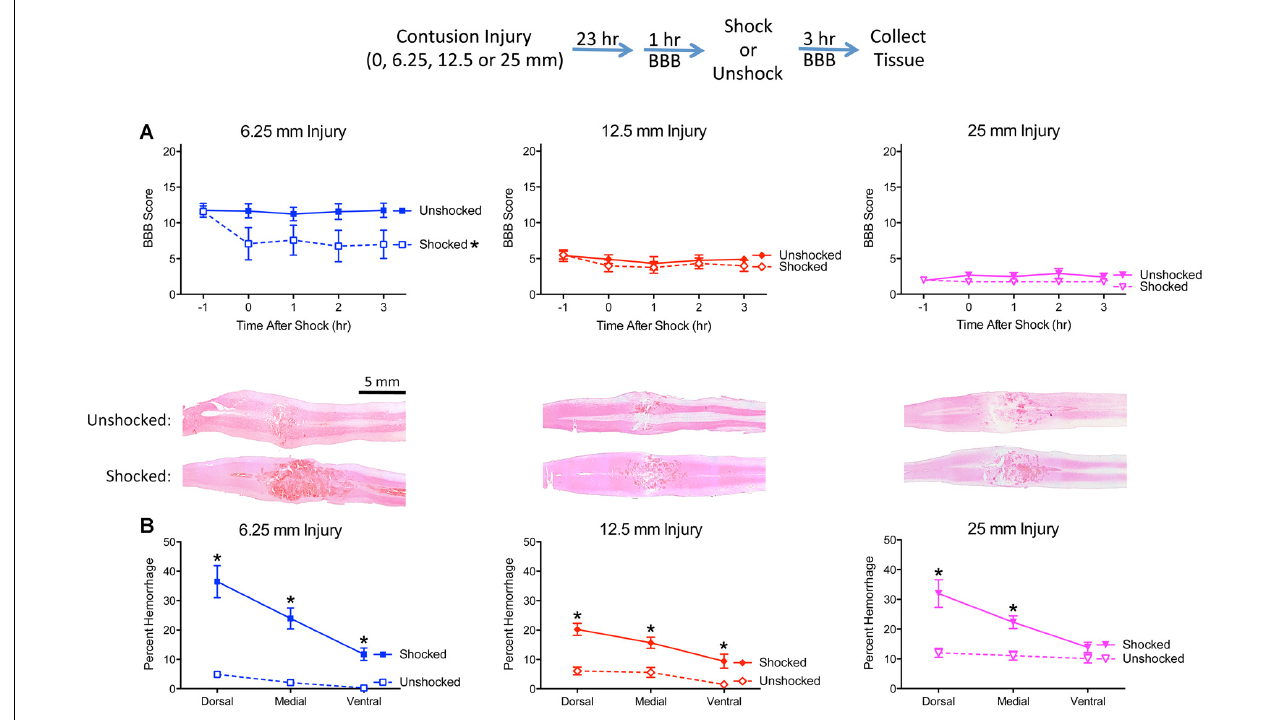
FIGURE 3 | Noxious electrical stimulation has a more robust effect after a mild (6.25 mm) contusion injury. The experimental design is illustrated at the top of the figure. Rats received a sham surgery (0 mm), mild (6.25 mm), moderate (12.5 mm), or severe (25 mm) contusion injury. (A) Locomotor performance prior to nociceptive stimulation ( − 1 h) declined as injury severity increased. Noxious electrical stimulation (Shocked) induced an acute disruption in motor behavior, relative to the unstimulated (Unshock) controls, and this effect was most evident after a mild (6.25 mm) injury. (B) Nociceptive stimulation increased histological signs of hemorrhage and this effect was most evident within the dorsal region in animals that received a mild (6.25 mm) injury. Nociceptive stimulation did not affect locomotor scores, or induce signs of hemorrhage, in sham-operated animals. Representative sections are from the dorsal region (bar = 5 mm). Error bars indicate the SEM. ∗ Indicates statistical significance ( p < 0.05, n =